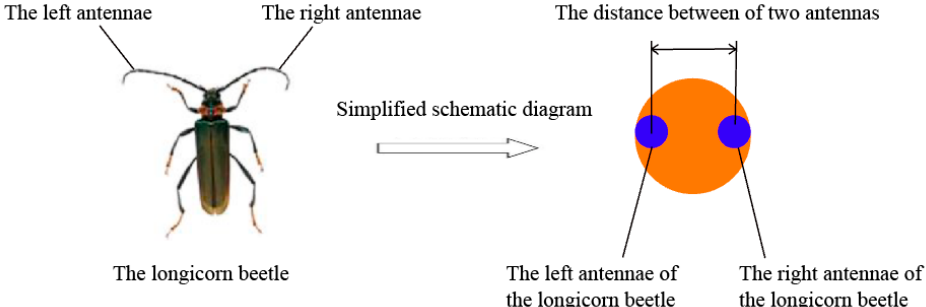
Figure 5. The diagram of the longicorn beetle. (Source: the Baidu website).